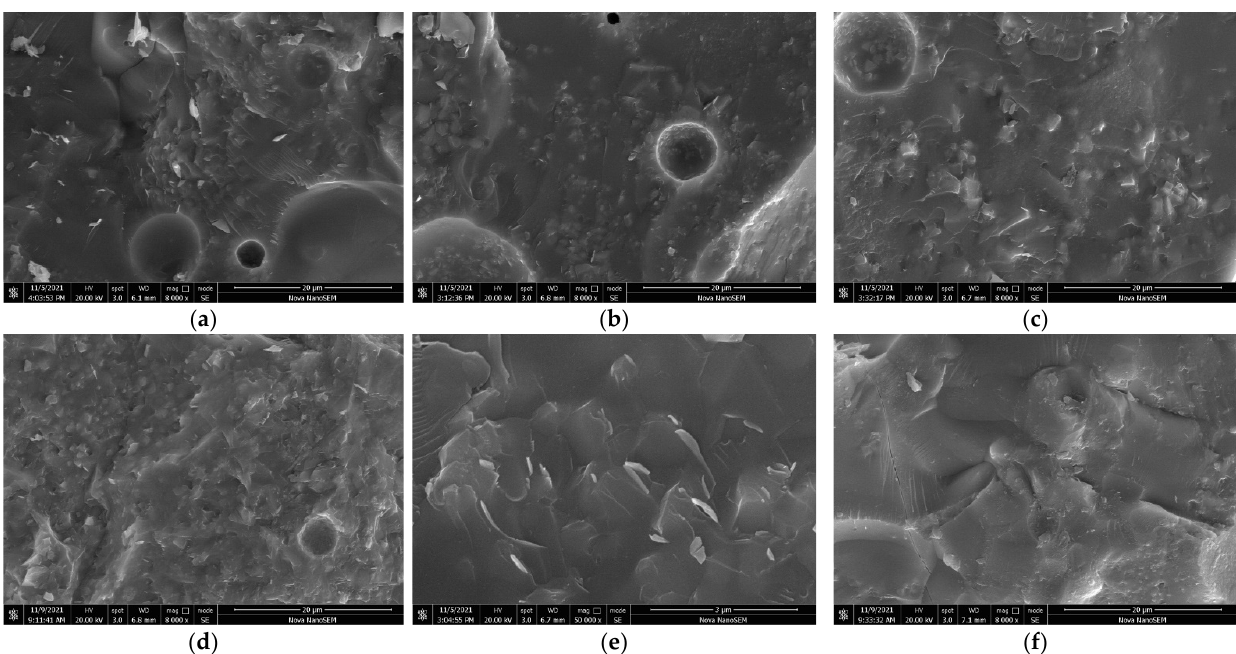
Figure 6. Surface microstructures of ceramsite at different sintering temperatures: ( a ) 1220 °C, ( b ) 1230 °C, ( c ) 1240 °C, ( d ) 1250 °C, ( e ) 1260 °C, ( f ) 1270 °C.